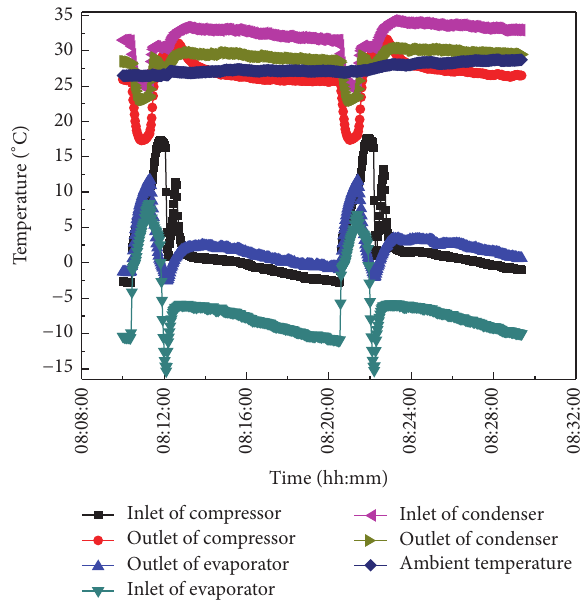
Figure 13: Temperature variations of ice maker components during two refrigeration thermodynamic cycle processes.